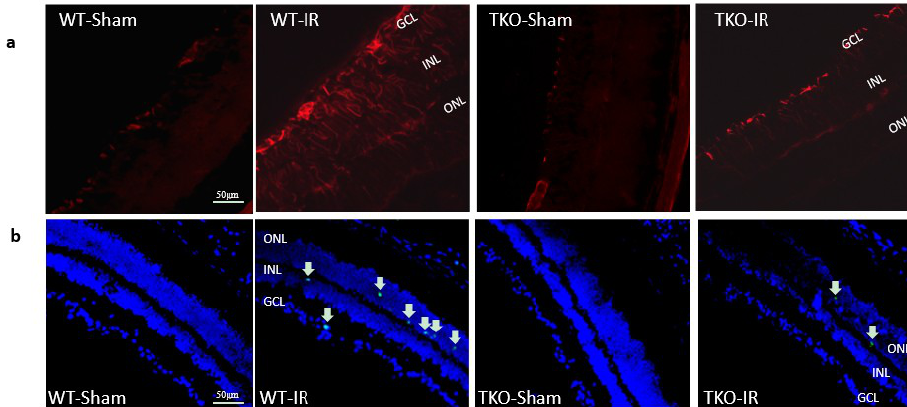
Figure 5. ( a ) Ischemia / Reperfusion (IR) induced strong activation of Muller cells, the main glia in the retina, assessed by GFAP radial staining after 3-days in WT-IR but not in TKO-IR when compared to shams. ( b ) Ischemia / Reperfusion (IR) sustained retinal cell death indicated by TUNEL-positive cells (arrows) after 3-days in WT-IR, but not in TKO-IR when compared to